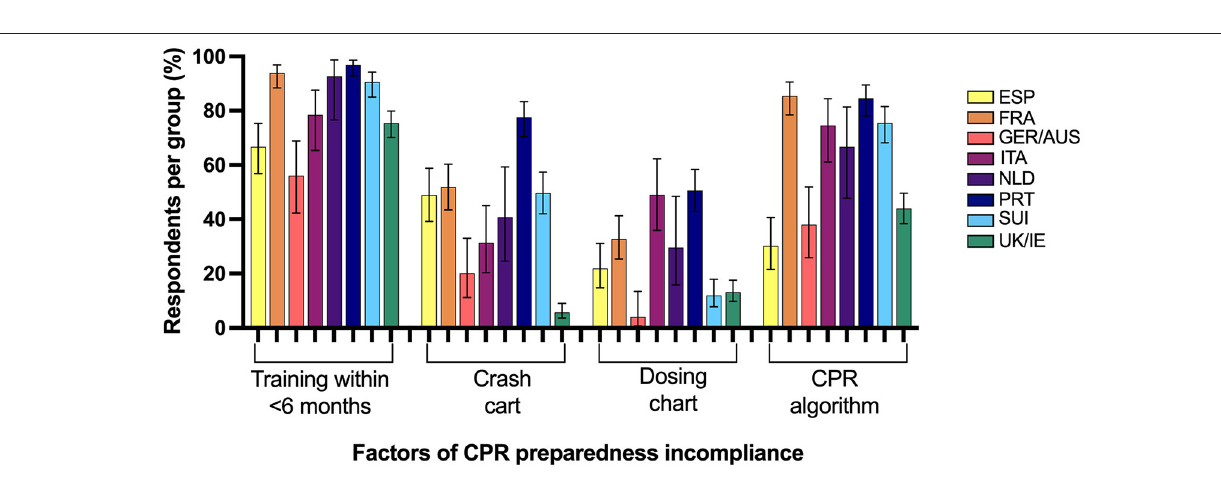
FIGURE 3 | Percentage of respondents from 8 Western European regions incompliant with cardiopulmonary resuscitation (CPR) preparedness RECOVER guidelines and the associated factors for failed compliance. ESP, Spain; FRA, France; GER/AUS, Germany/Austria; ITA, Italy; NLD, Netherlands; PRT, Portugal; SUI, Switzerland; UK/IE, England/Northern